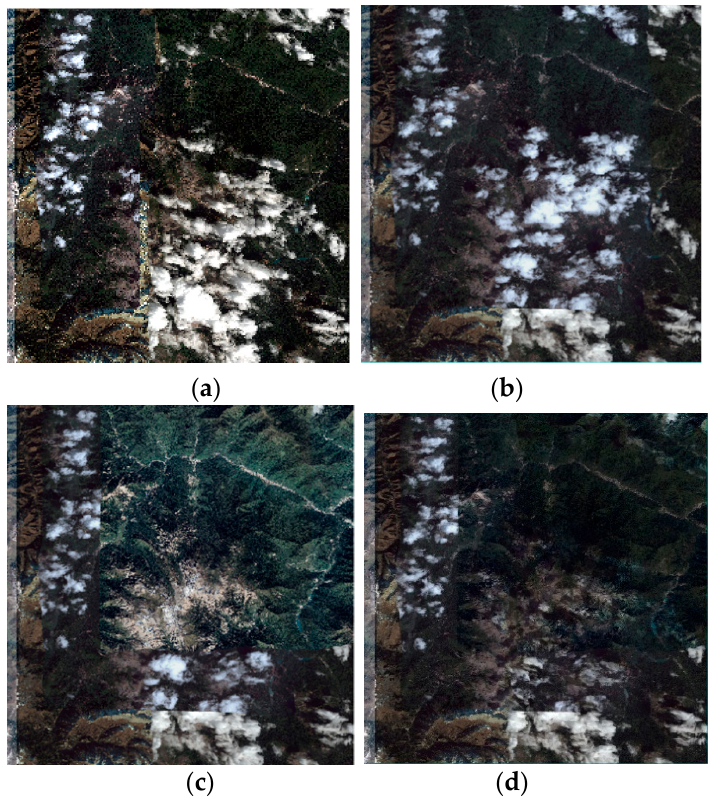
Figure 6. Post-event image demonstration collected from Google Earth: ( a ) image taken on 13 August 2017; ( b ) image taken on 14 August 2017; ( c ) image taken on 27 September 2019; ( d ) synthesized image.